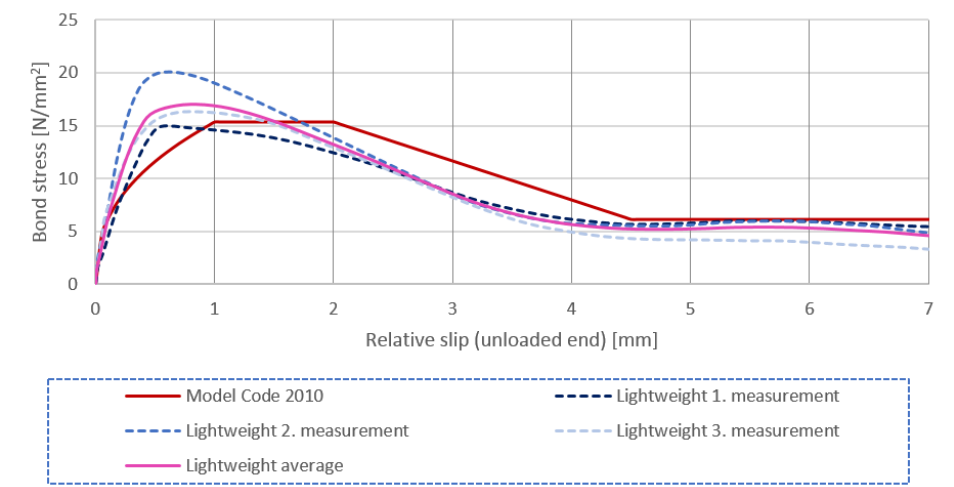
Figure 6. Bond stress–slip curves based on our measurements and the Model Code 2010.